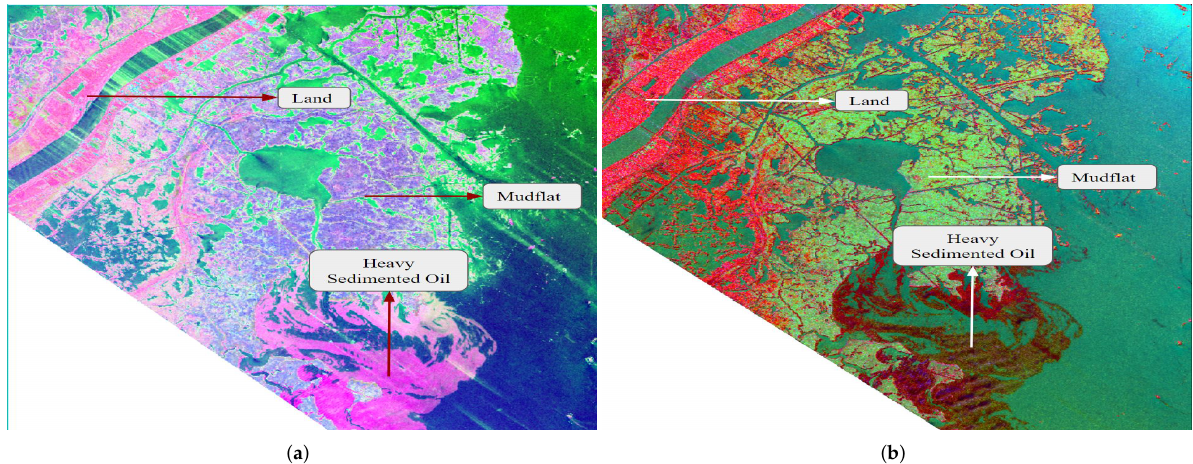
Figure 10. Comparative analysis of images generated by combining entropy (red), anisotropy (green) and alpha(black) ( H / A / α ) using conventional T3 ( a ) and log transformed T3 ( b ) showing their capability in differentiating between highly sedimented oil and